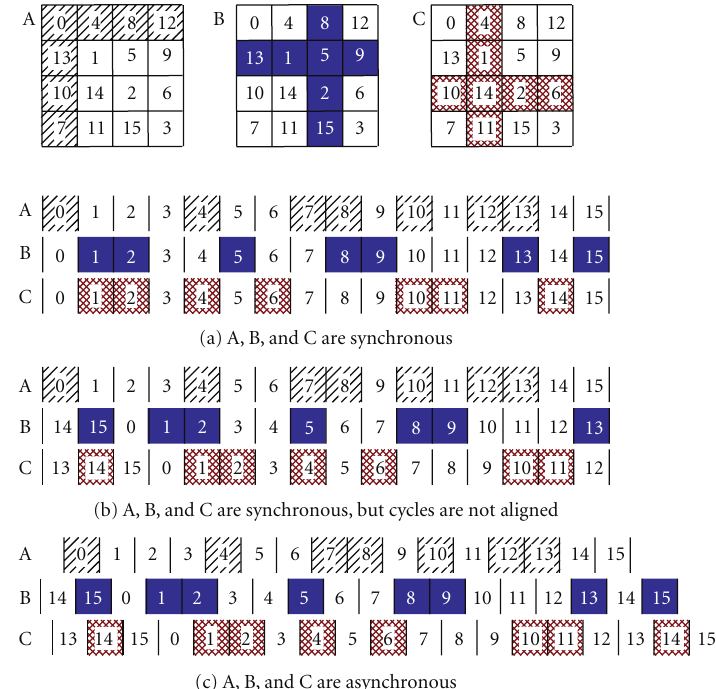
Figure 4: Grid-Diagonal QS distribution example.